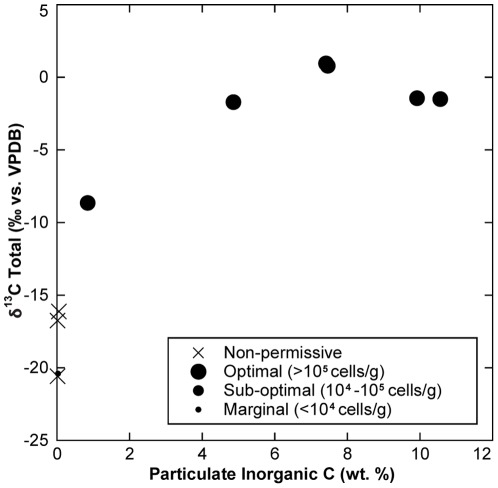
Inorganic carbon content versus δ13CTotal for sediment particulate material collected in selected Great Basin springs highlighting higher incidence and abundance of Korarchaeota in springs that are actively precipitating carbonate, as indicated by high inorganic C content and heavy δ13CTotal values.